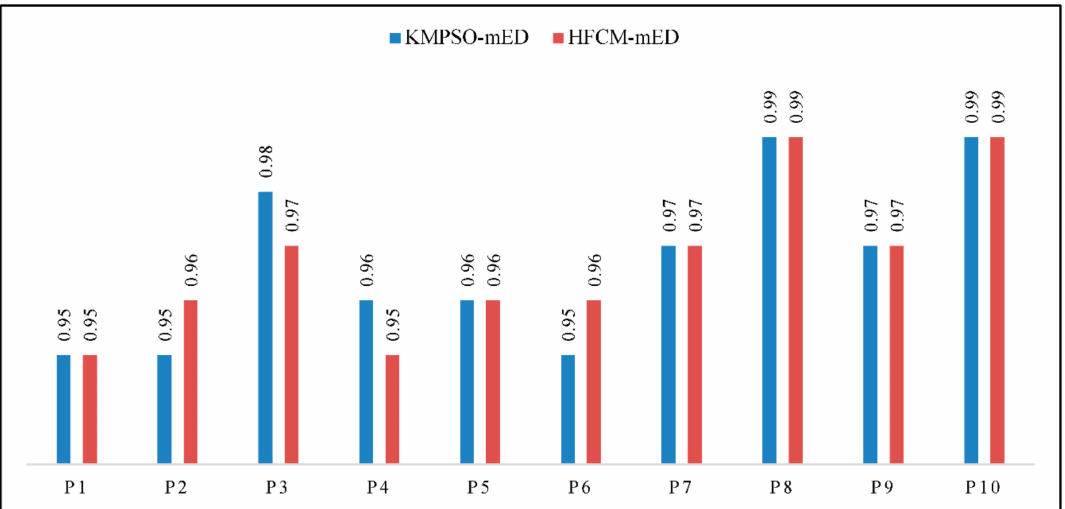
Figure 9. Comparison of KMPSO-mED, HFCM-mED for 10 Patients.